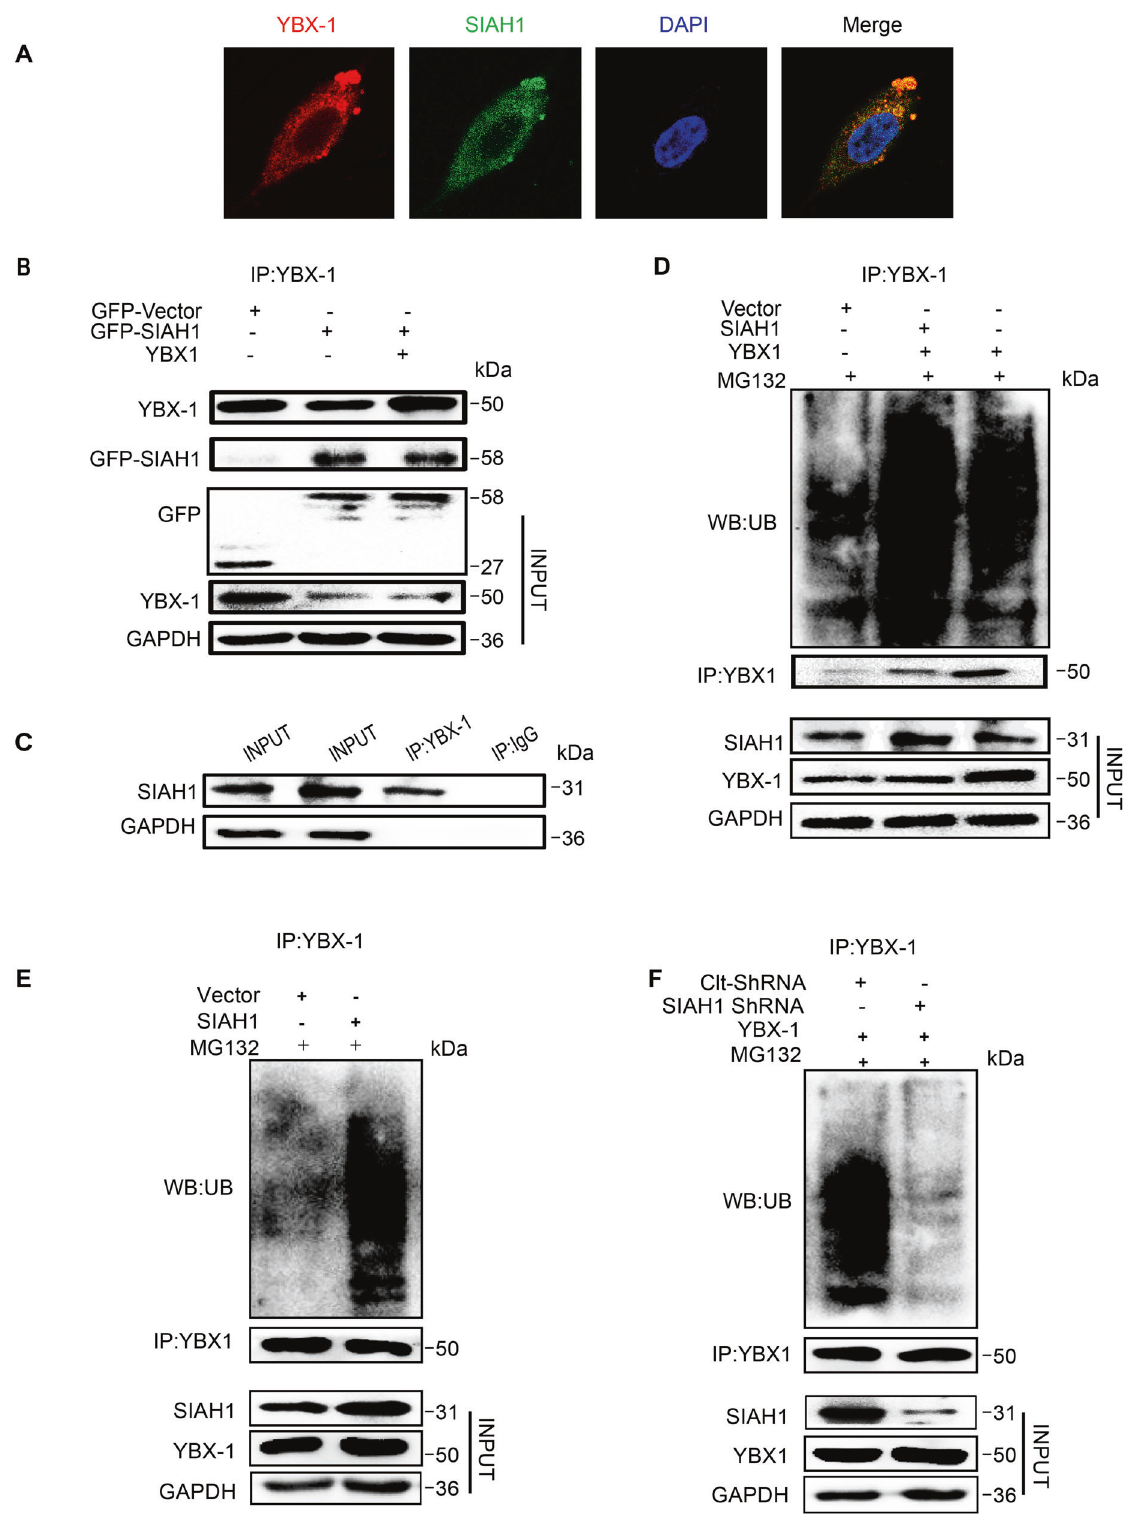
Fig. 5 YBX-1 is ubiquitinated by E3 ligase SIAH1. A A2780 cells were cotransfected with GFP-SIAH1 plasmids (green) and Cherry-YBX-1 plasmids (red). B IP of GFP-SIAH1 and YBX-1. 293 cells stably expressing GFP-SIAH1 were pulled down by anti-YBX-1 and immunoblotted with anti- GFP. C IP of endogenous SIAH1 and YBX-1. 293 cells lysates were pulled down by anti-YBX-1 and anti-IgG, then immunoblotted with anti-SIAH1. D , E HEK293T cells were cotransfected with GFP-SIAH1 and FLAG-YB-1 or GFP-SIAH1 Individually, The cell lysates were immunoprecipitated with anti- YBX-1 antibody. The ubiquitinated YBX-1 was detected by immunoblotting using an anti-UB antibody. Cells were treated with 10 μ M MG132 for 6 h before pulling down. F HEK293T cells were cotransfected with YBX-1 and SIAHI ShRNA, YBX-1 and Clt-ShRNA, respectively. The cell lysates were immunoprecipitated with anti-YBX-1 antibody. The ubiquitination was checked the same as mentioned above.